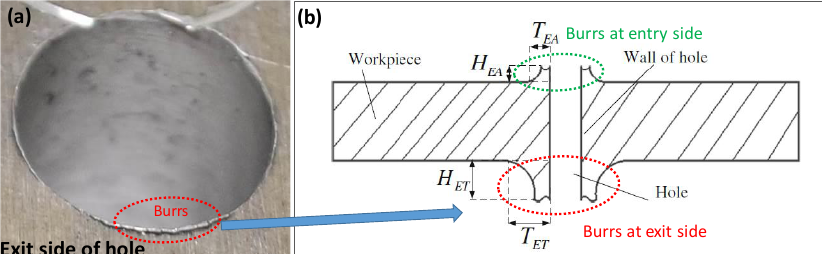
Figure 7. ( a ) Representative hole with burrs at the exit side of a hole ( b ) definition of burr geometry.